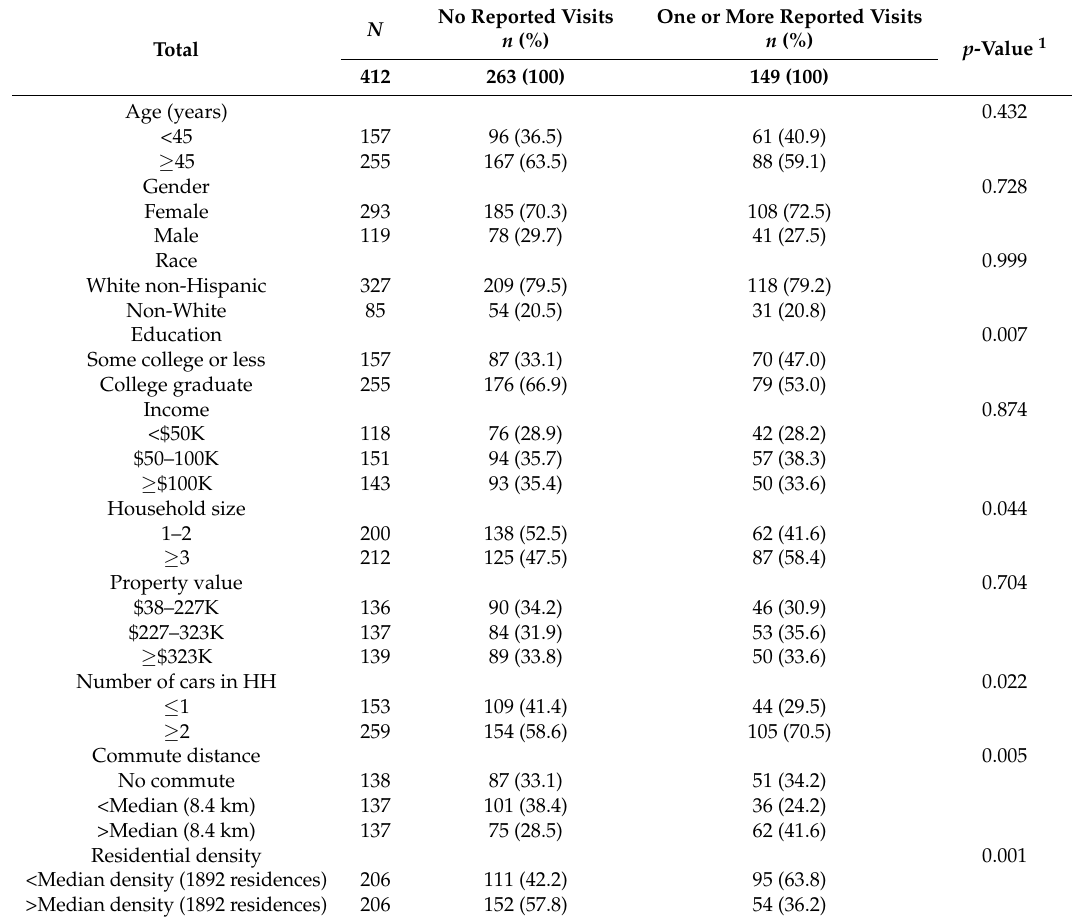
Table 1. Descriptive characteristics of FFR (fast food restaurant) visitors and non-visitors.